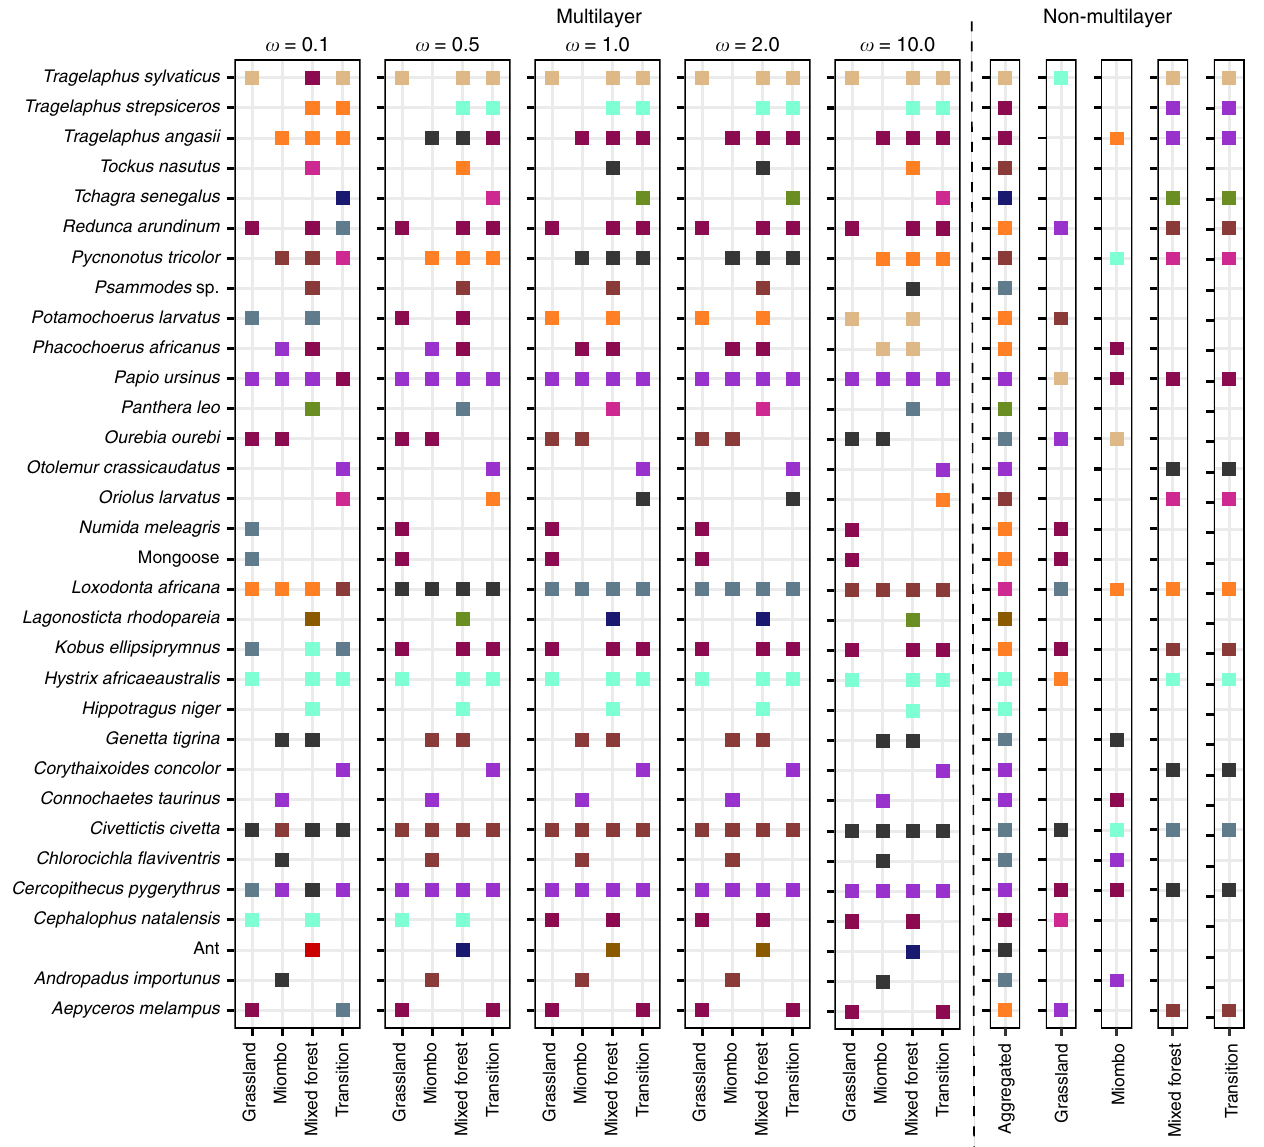
Fig. 3 Module af fi liation of animal species in the spatial multilayer network of Gorongosa. Module af fi liation is shown for fi ve different interlayer edge strengths (left block), and for the monolayer networks, considering either the aggregated network or each habitat individually (right block). In each case, the run with the highest maximized modularity was used (module af fi liation for plant species is shown in Supplementary Fig. 2). Within each network, different colors represent different modules. Colors in different blocks are